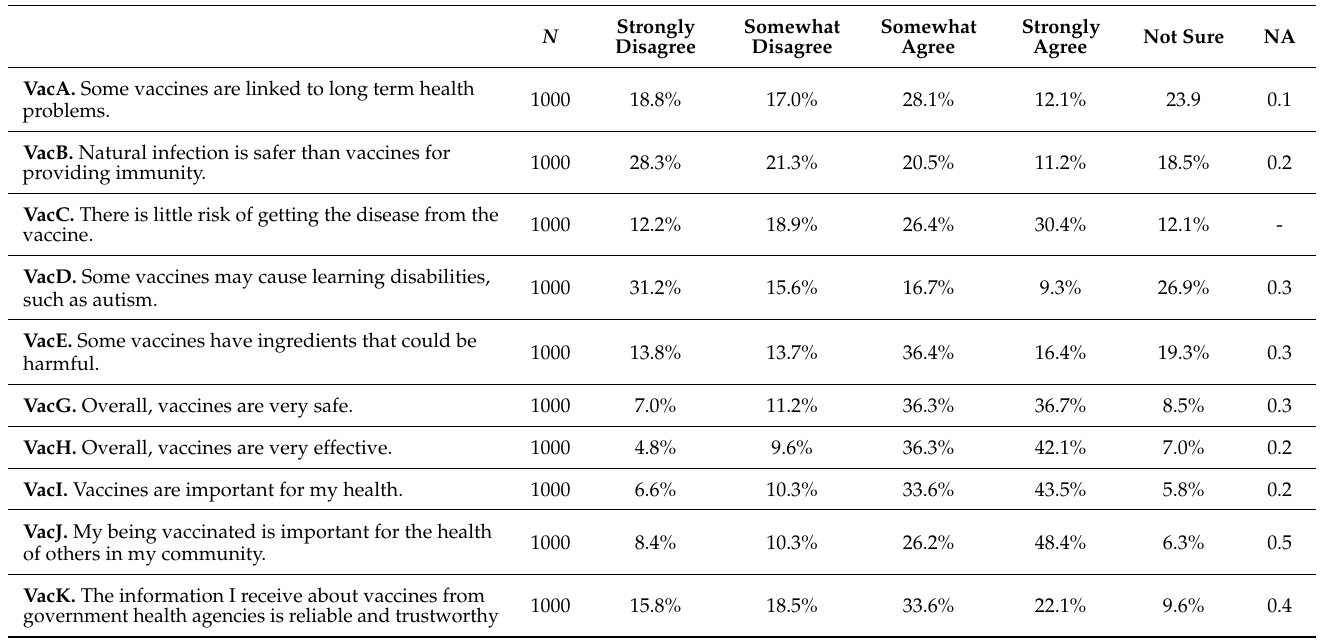
Table 1. General beliefs about vaccines: August 2021